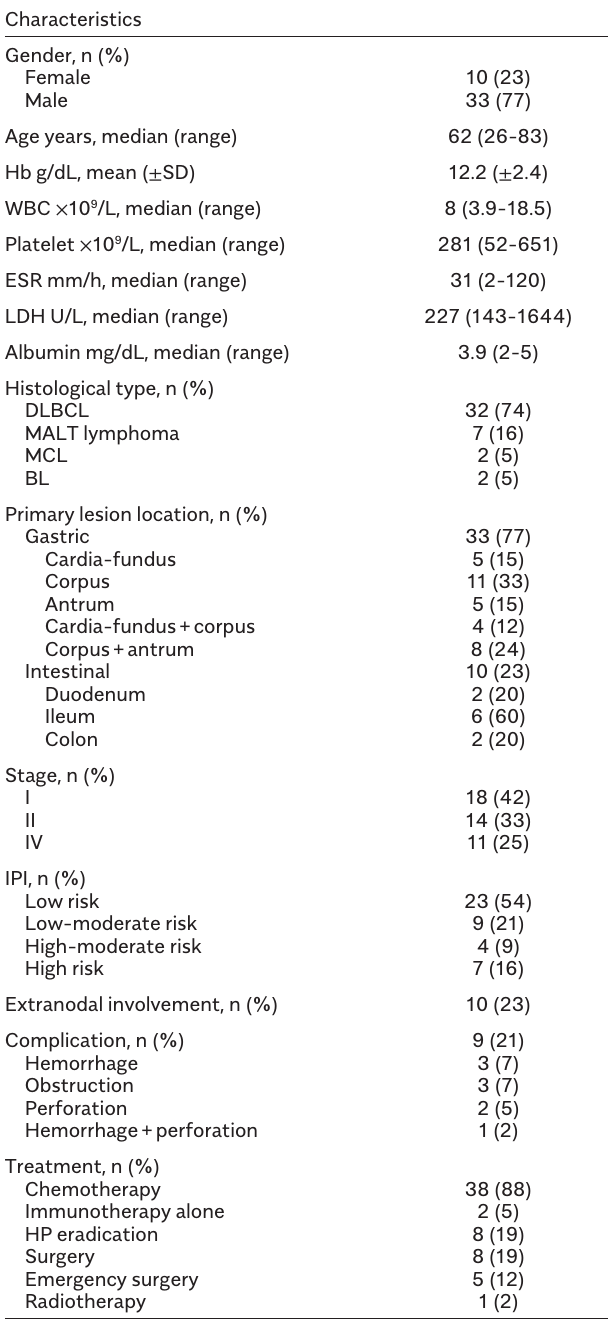
Table 1. Characteristics of Patients with Primary Gastrointestinal Lymphoma